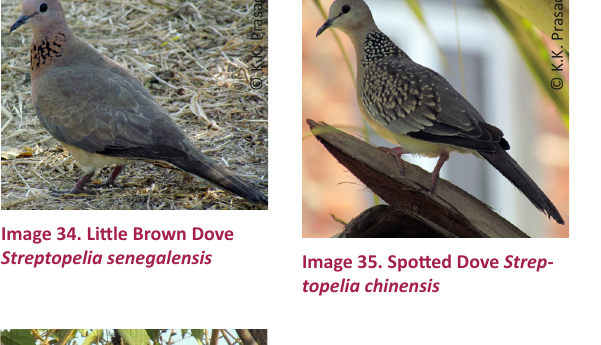
Image 36. Rose-ringed Parakeet Psittacula krameri